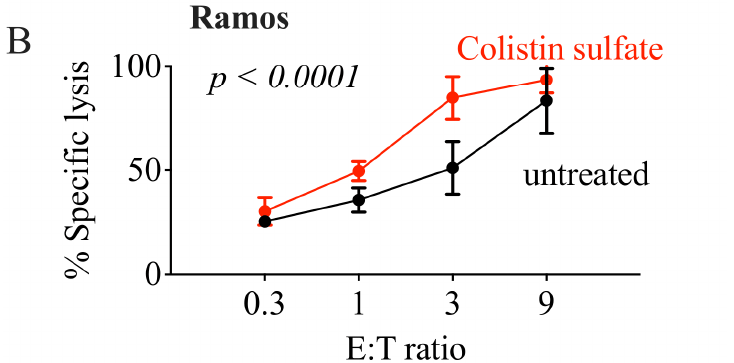
Figure 5. Treatment with colistin sulfate increases NK92 cytotoxicity against K562 and Ramos cells. NK92 cells were mixed with K562-NL ( A ) or Ramos-NL ( B ) cells and seeded into a 96-well V bottom plate at a 0.3:1, 1:1, and 3:1 E:T ratio with 10,000 K562-NL cells per well and treated with 10 μ M of colisltin for 5-h at 37 °C. After incubation, the supernatant was collected and transferred to a 96-well black plate. The Biotek Synergy microplate reader (Winooski, WI, USA) was used to dispense CTZ and read luminescence. Percent specific lysis is depicted. Mean +/ − SD of three technical replicates, the experiment was repeated twice. Statistical analysis with two-way ANOVA.